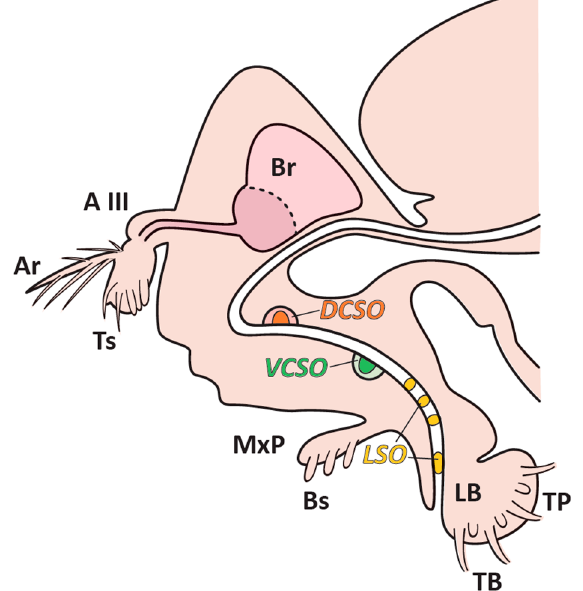
Figure 1. Drosophila melanogaster head with olfactory organs, antennae, maxillary palps (Mxp), gustatory organ, and propobscis presented with their sensilla. Antennae with third antennal segment (A III), arista (Ar), and trichoid sensillum (Ts). Mxp with basiconic sensillum (Bs). The labellum (LB) with taste bristle (TB) and taste peg (TP), and three internal taste organs indicated (i) the labral sense organs (LSOs) in yellow; (ii) the ventral cibarial sense organ (VSCO) in green; and (iii) the dorsal cibarial sense organ (DSCO) in orange. Brain (Br) (Figure adapted from